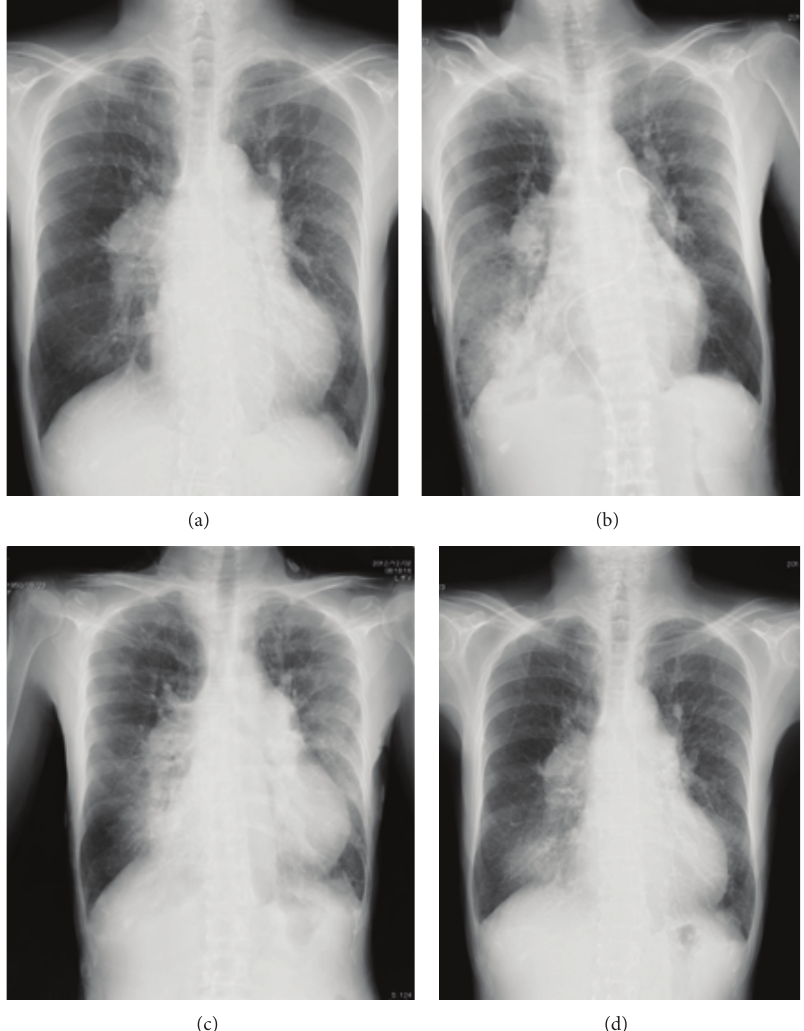
Figure 1: Chest X-ray obtained before percutaneous transluminal pulmonary angioplasty (a), on the first postoperative day (POD1) (b), POD4 (c), and POD8 (d). The patient had localized consolidation and atelectasis on her right lower lobe on POD1, 4, and 8, designating postsurgical pulmonary edema in the dilated